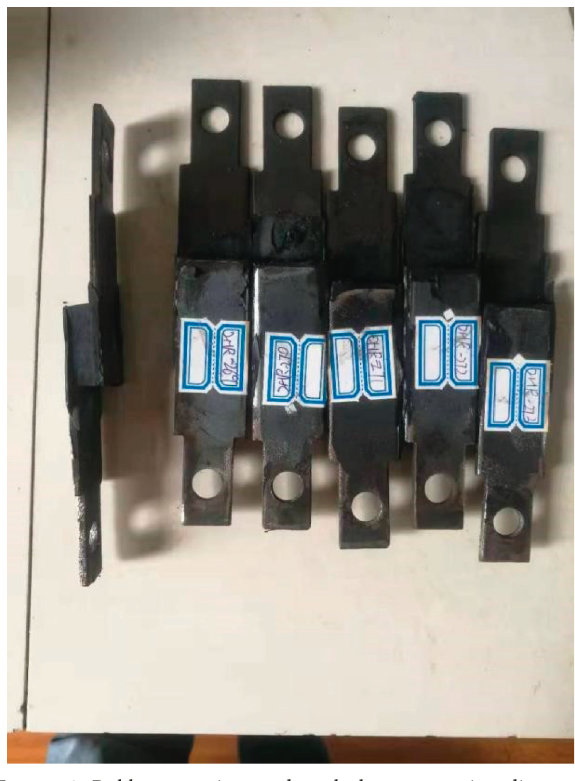
Figure 3: Rubber test piece and steel plate connection diagram.